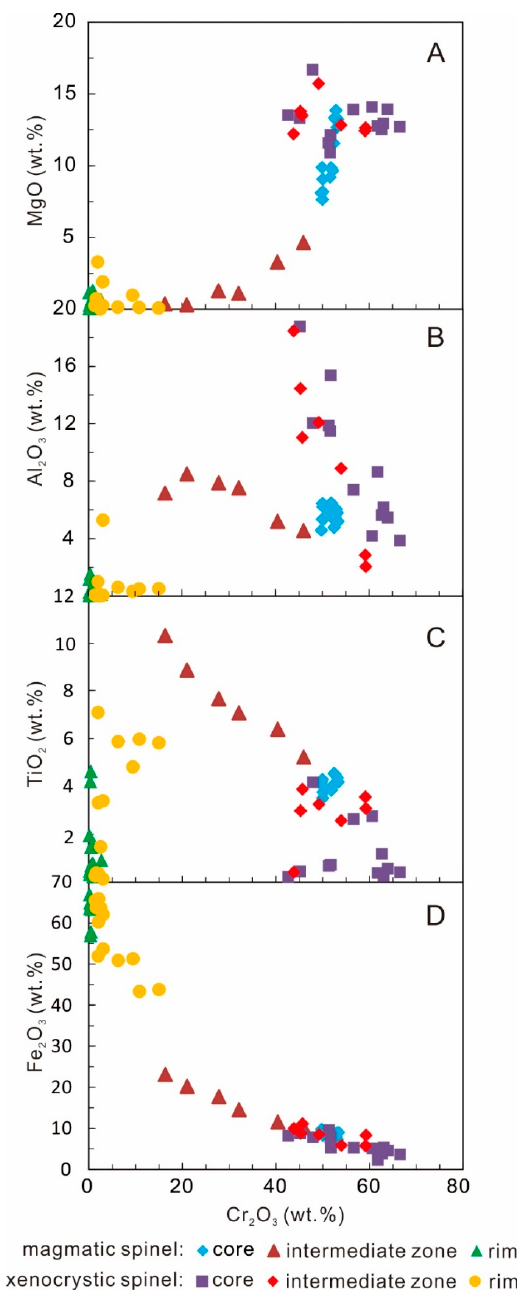
Figure 2. Variations of MgO ( A ), Al 2 O 3 ( B ), TiO 2 ( C ), and Fe 2 O 3 ( D ) versus Cr 2 O 3 contents in the magmatic and xenocrystic spinels from the No.30